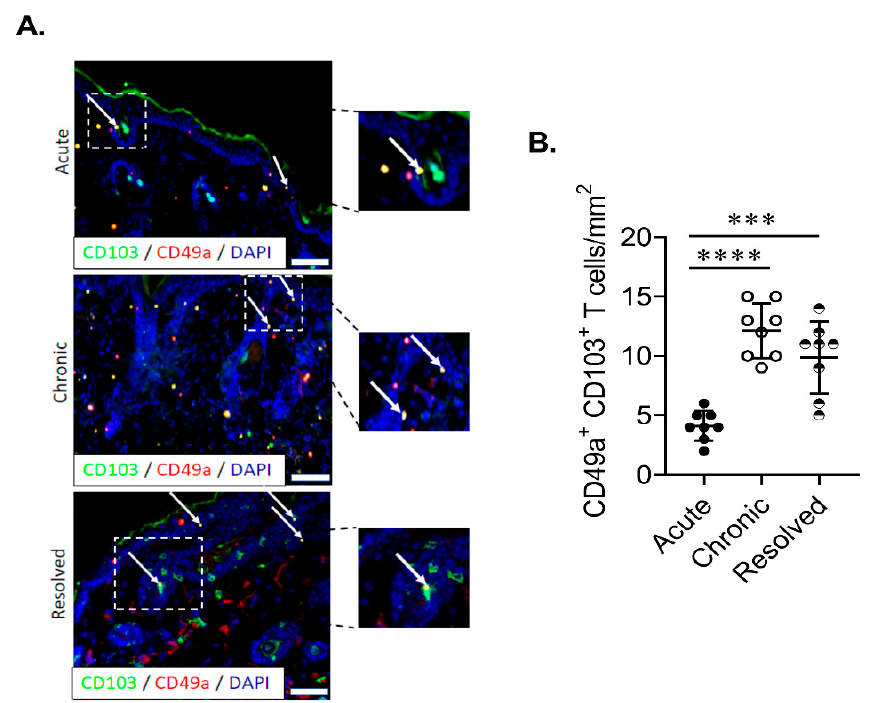
Figure 4. Epidermal Trm cells remain elevated in the murine skin of resolved psoriasiform dermatitis. ( A , B ) Representative images and quantitation of CD103 + CD49a + Trm cells in the epidermis of mice with acute, chronic and resolved psoriasiform dermatitis. Each dot represents one mouse skin sample ( n = 8 / group). Data are presented as mean ± SD. *** p < 0.001, **** p < 0.0001.